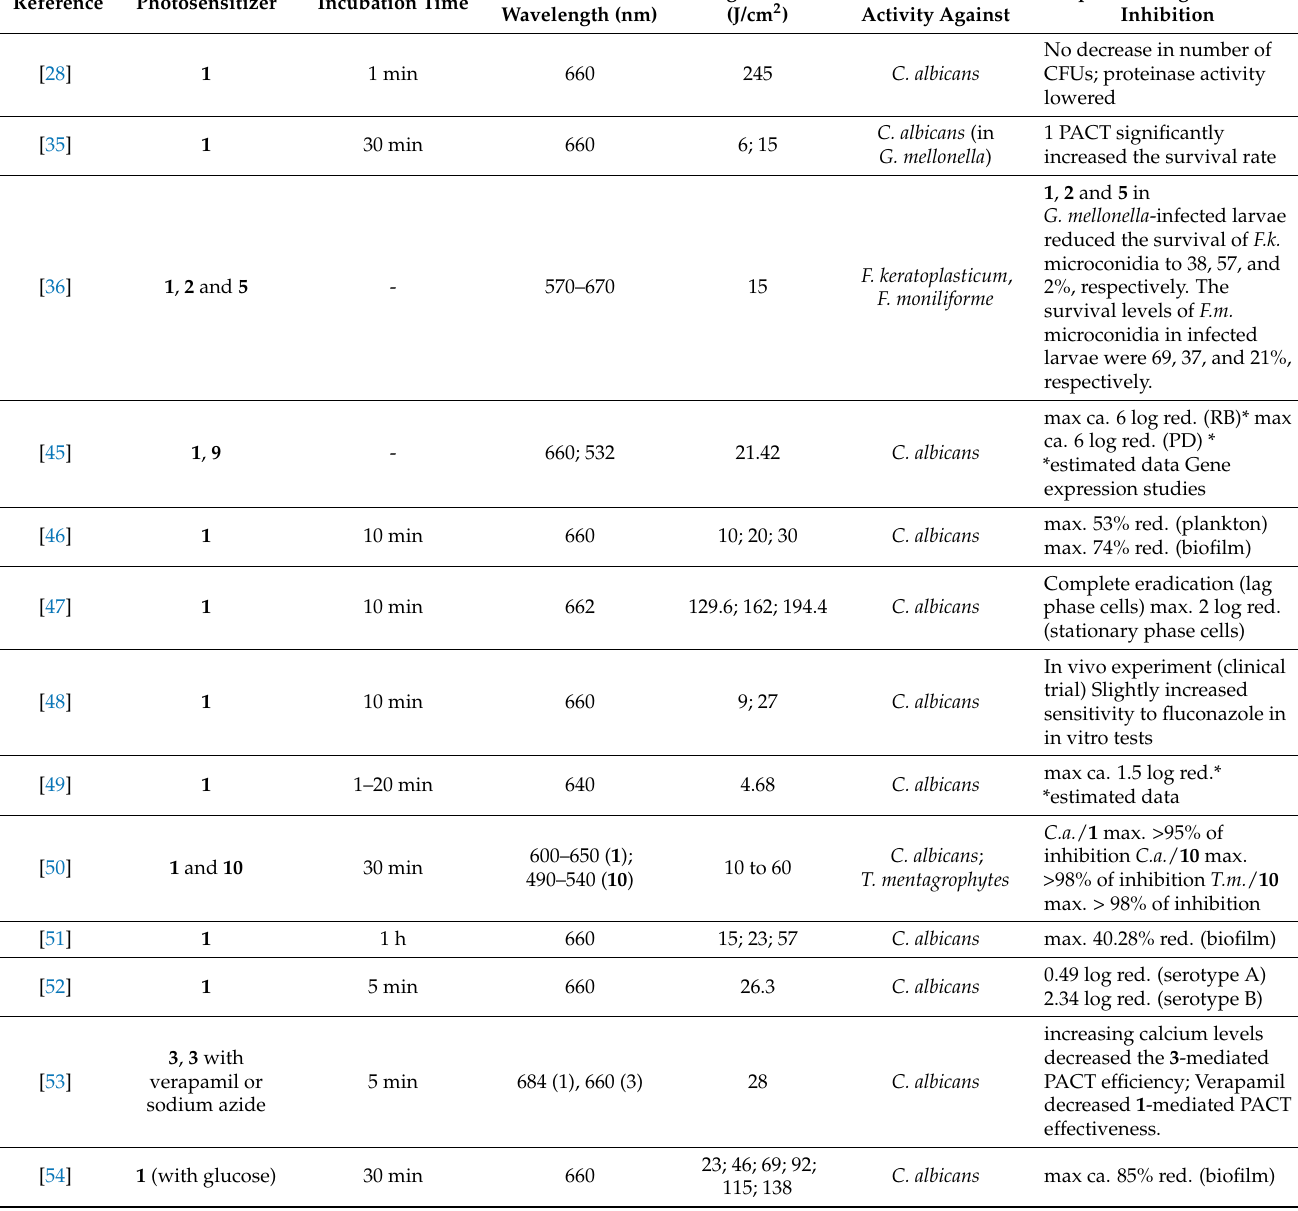
Table 1. Phenothiazines—photodynamic antimicrobial activity and